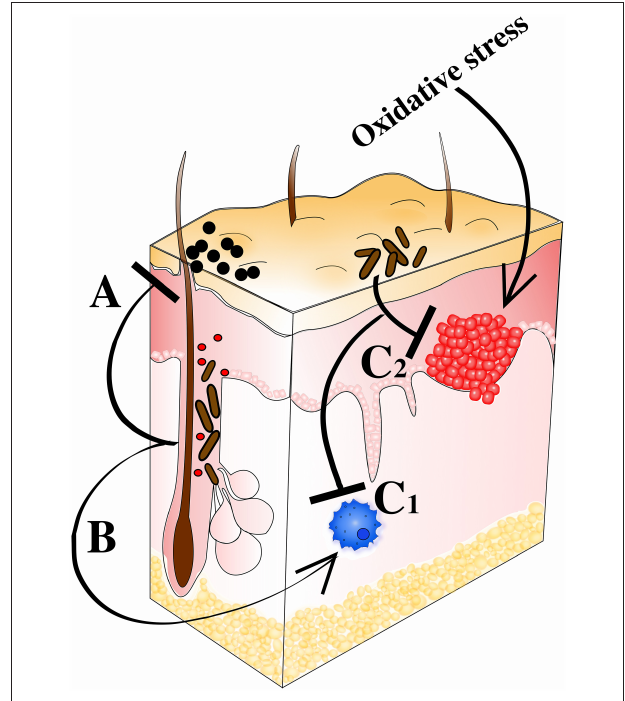
FIGURE 4 | C. acnes’ prospective probiotic qualities. (A) Colonization resistance against staphylococci and other potential pathogens. Direct effects through expression of SCFAs (e.g., propionic acid) and bacteriocins (e.g., cutimycin). Indirect effects through induction of host-derived AMPs (e.g., HBD and LL-37). (B) Modulation of immune response including e.g., Th1 and Th17 priming leading to heightened intrinsic anti-tumor activity and clearance of pathogens. Interactions with Langerhans cells also help shape host immune defenses. (C1) Inflammation regulation via RoxP, CLAs, polysaccharides, and SCFAs (pro- and anti-inflammatory qualities). (C2) Counteracting the tumorigenic effect of oxidative stress through RoxP secretion.